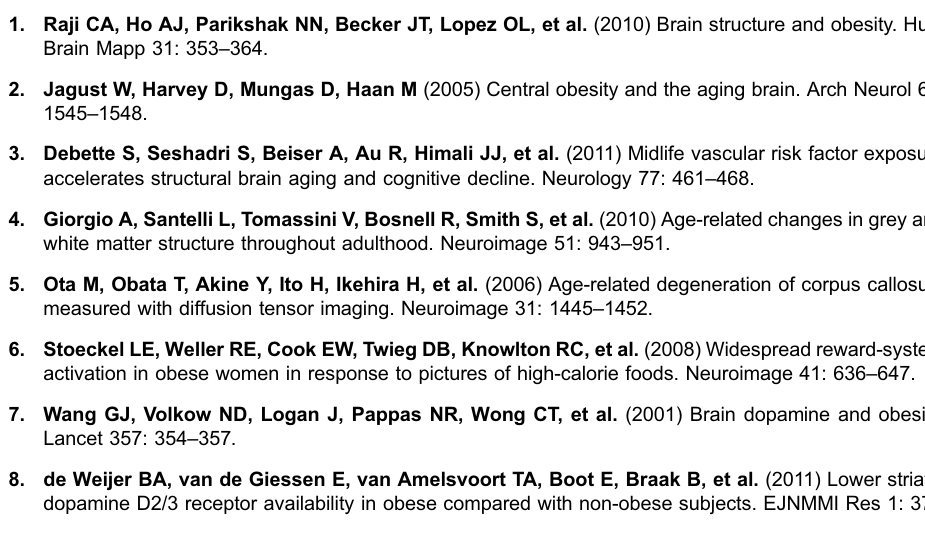
Table S1. Cohort description including age, body weight and height, body- mass index (BMI), waist-to-hip ratio (WHR), and further blood serum concentrations of insulin, proinsulin, glucose, leptin, soluble leptin receptor (sOB-R), triglycerides, albumin, protein, brain-derived neurotrophic factor (BDNF), C-peptide, cholesterol, low-density lipoprotein (LDL), high-density lipoprotein (HDL), thyroid-stimulating hormone (TSH), cortisol, creatinine, chloride (Cl), potassium (K), sodium (Na), and osmotic concentration. Table S2. Cohort description including behavioral parameters as cognitive restraint, compulsive behavior, disinhibition, hunger, and parameters for graduation and living